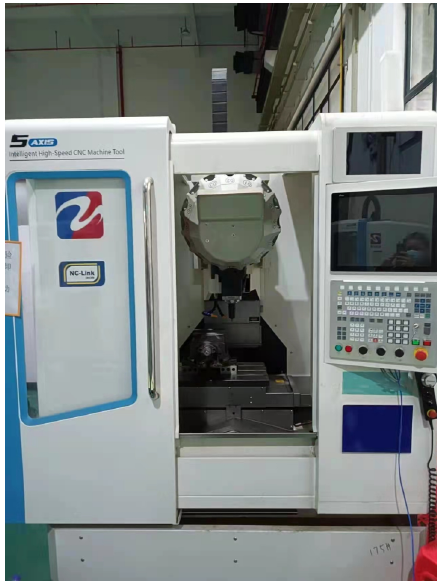
Figure 2. Schematic of thermal analysis of ball screw feed